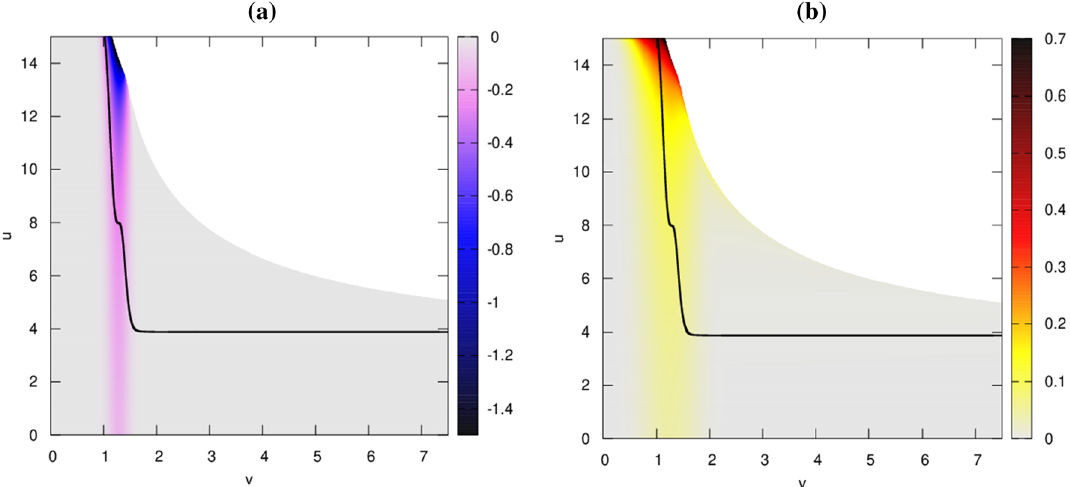
Fig. 16 The (v u ) -distribution of a the neutral scalar field, h , and b the moduli of the complex scalar field, | s | , for the same parameters and field amplitudes as in Fig.